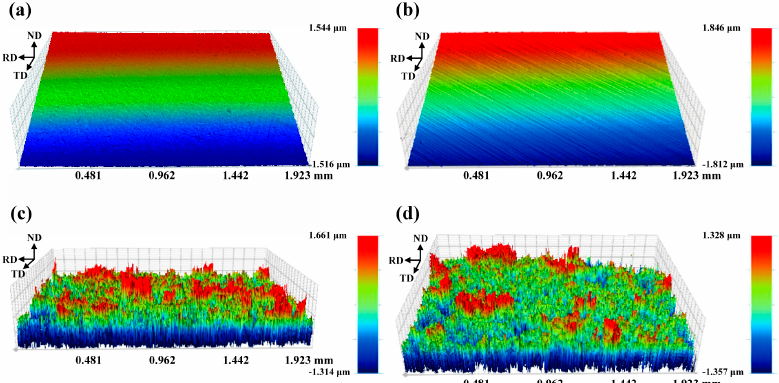
Figure 3. The 3D contour profiles of the ( a ) ground 304 plate, ( b ) ground 316 plate, ( c ) micro-shot peened 304 plate and ( d ) micro-shot peened 316 plate. The roughness values are listed in Table 1.